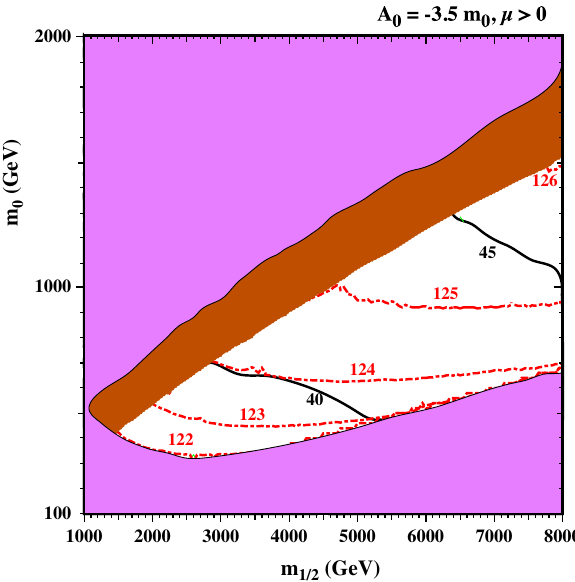
Fig. 2 Higgs mass contour plot in the plane ( m 1 / 2 - m 0 ) for the CNMSSM scenario. We depict in magenta the region of the parameter space excluded by any of the following reasons: existence of another vacuum deeper than the EW one; the presence of a tachyonic parti- cle; experimental constraints from LEP, LHC and others (see text for a detailed description). In the brown shaded area the stau is the LSP while in the white area the neutralino is the LSP. Red dashed contours account for the Higgs mass (in GeV), while the black lines represent the value of tan β